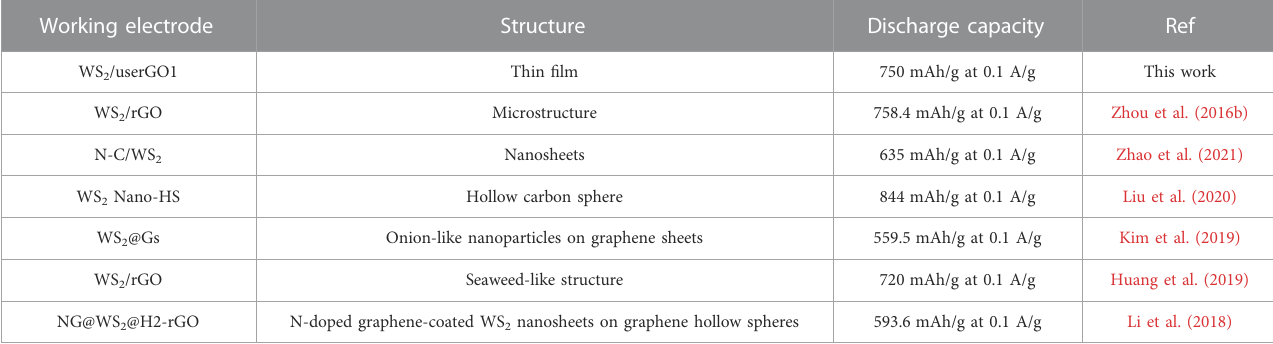
TABLE 3 Comparison of different WS 2 -based structures and their performance in LIBs. Working